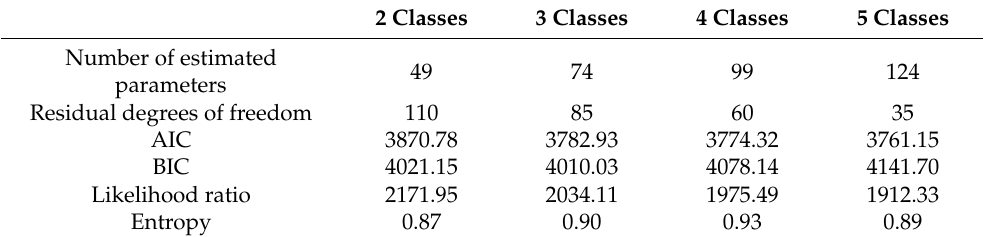
Table 3. Goodness-of-fit criteria.